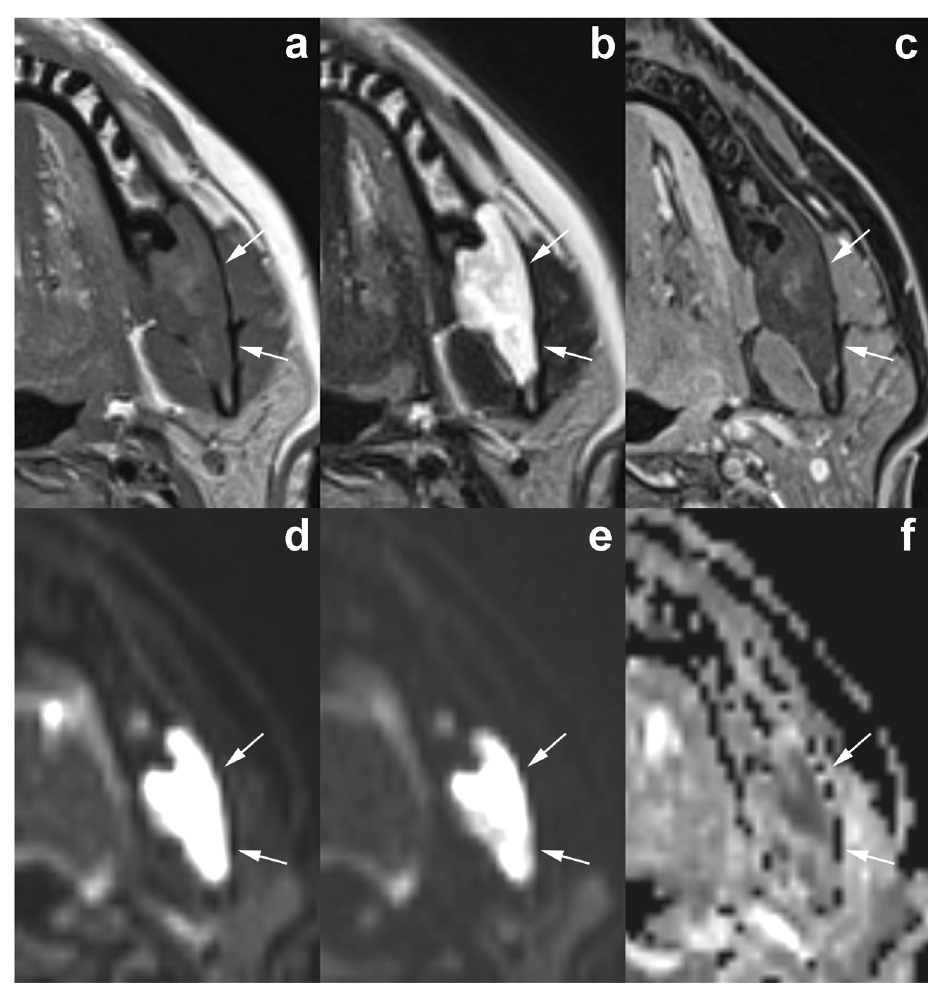
Fig. 15 Axial magnetic resonance imaging (MRI) images demonstrate the typical signal pattern of OKC. The lesion, located in the posterior left mandible ( arrows ), shows intermediate-high signal intensity on T1-weighted sequence ( a ) and heterogenoushighsignal intensity on T2-weighted sequence ( b ). No enhancement is observed within the lesion on enhanced T1- weighted fat-saturated sequence ( c ). Diffusion-weighted imaging demonstrates restricted diffusion with high signal on b0 ( d ) and b1000 ( e ) images and low signal intensity on apparent diffusion coefficient (ADC) map ( f